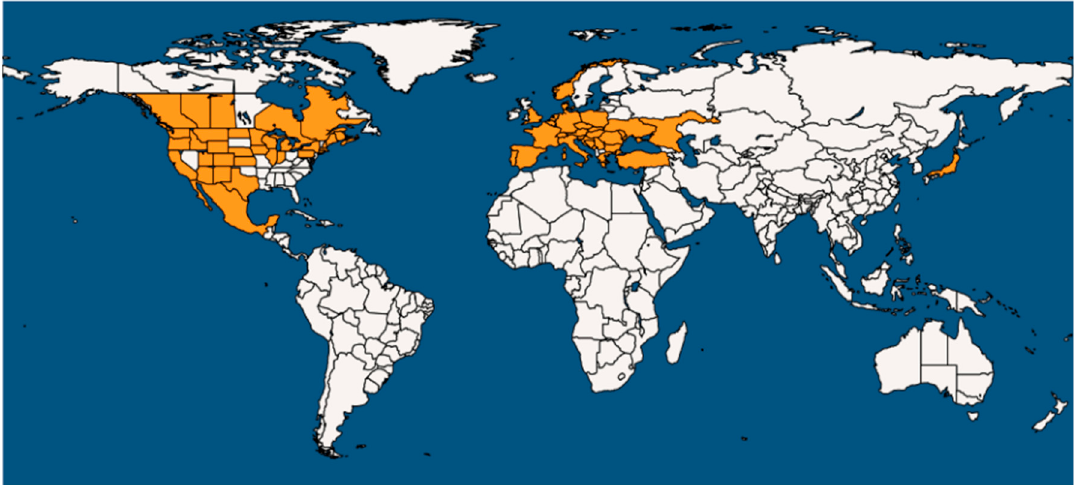
Figure 2. Current distribution of Leptoglossus occidentalis around the world (source: EPPO http://www.eppo.int).